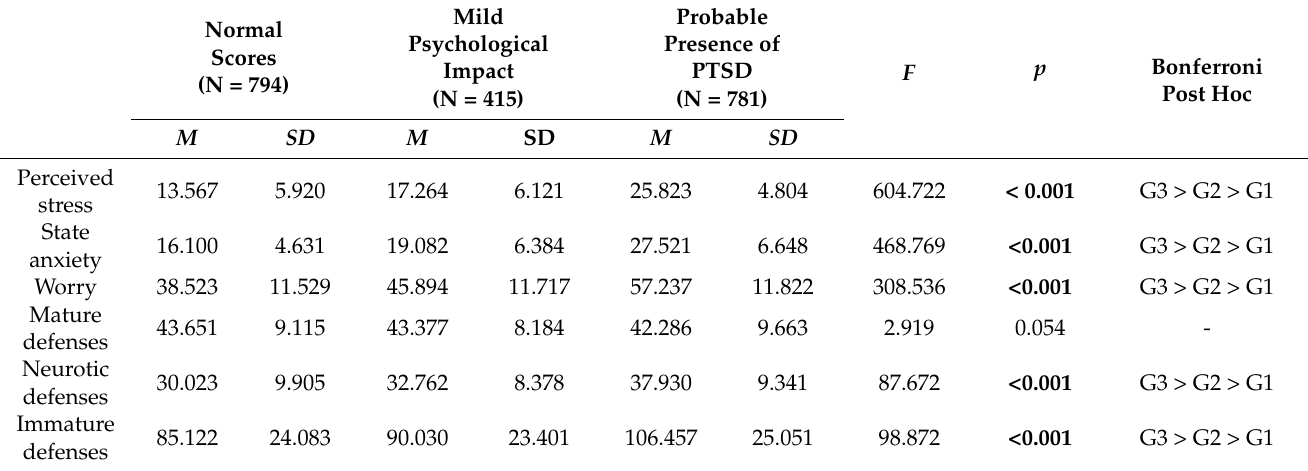
Table 1. Means, standard deviation and comparisons of perceived stress, state anxiety, worry, and defense mechanisms (mature, neurotic, and immature) based on the levels of post-traumatic stress symptoms.